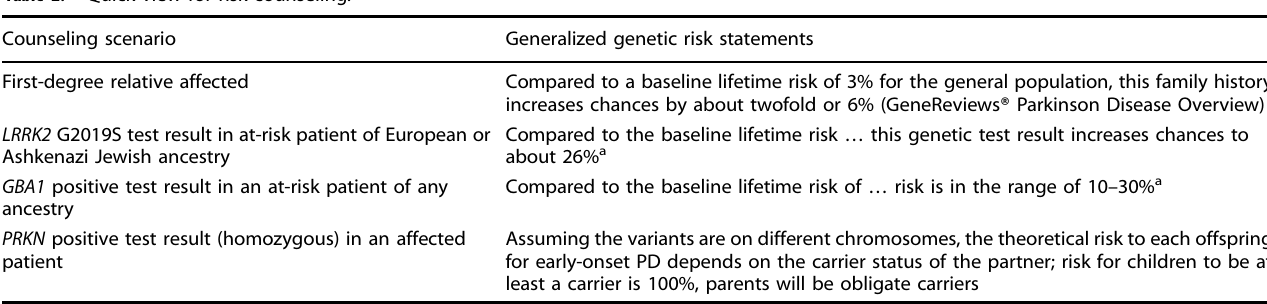
Table 2. Quick view for risk